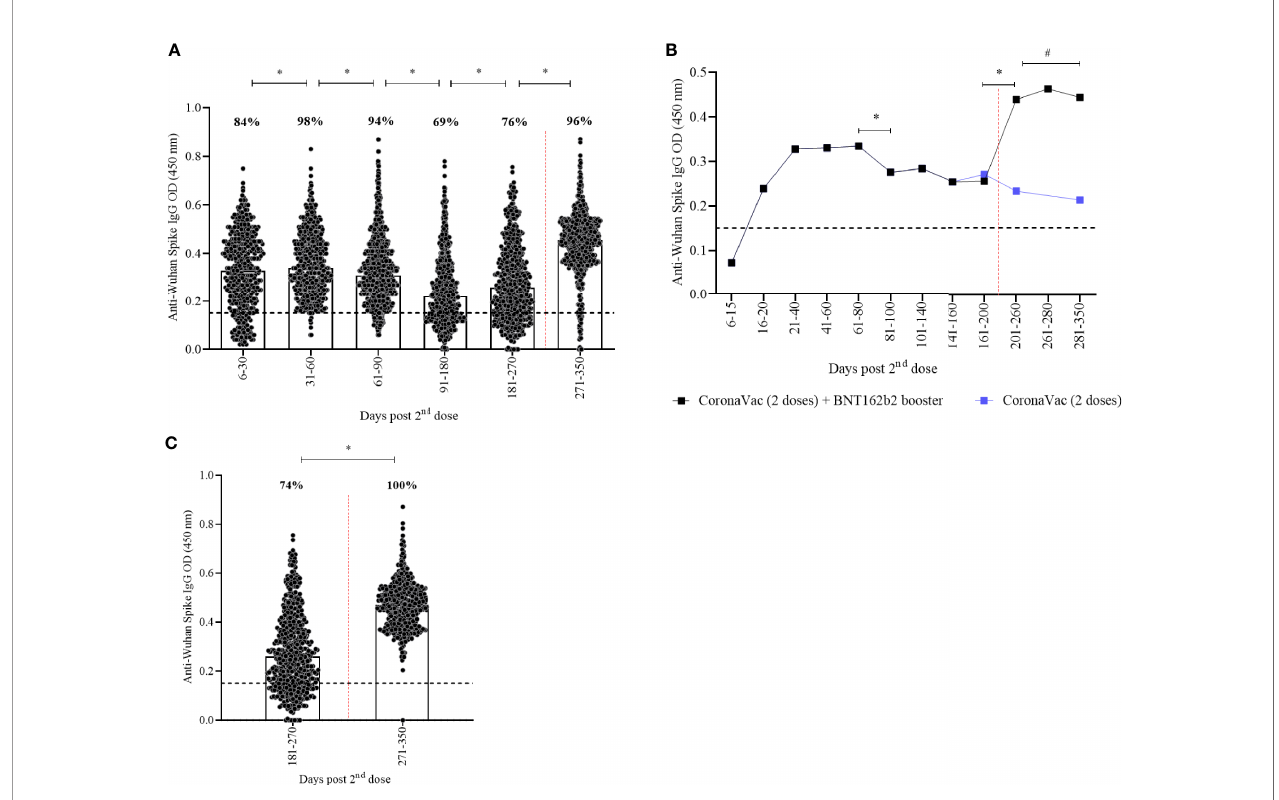
FIGURE 1 | Kinetics of anti-spike IgG levels over a one-year period of CoronaVac in a two-dose primary protocol and BNT162b2 heterologous booster. Median OD of anti-spike IgG, measured by ELISA, is represented by bars, percentage values indicate seropositivity rate. The limit of detection of 0.1508 is represented by the black lines. Red dotted lines represent booster dose timepoint. In (A, C) individual points present each vaccinated participant. In (B) median of anti-spike IgG are shown. Mann-Whitney and ANOVA statistical differences are presented by letters for comparisons over timepoints (*) and comparison between recipients with or without the booster dose